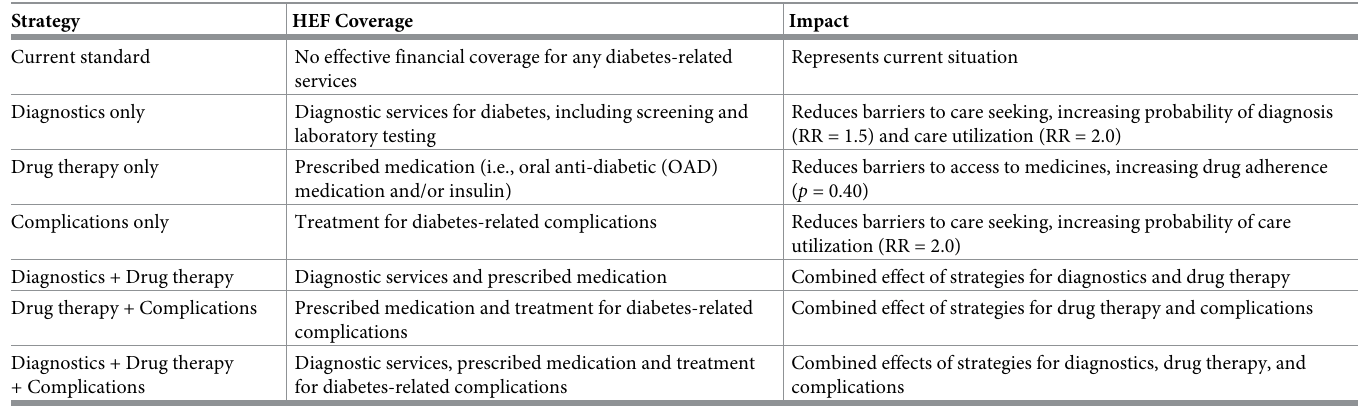
Table 1. Description of strategies analyzed and their hypothetical